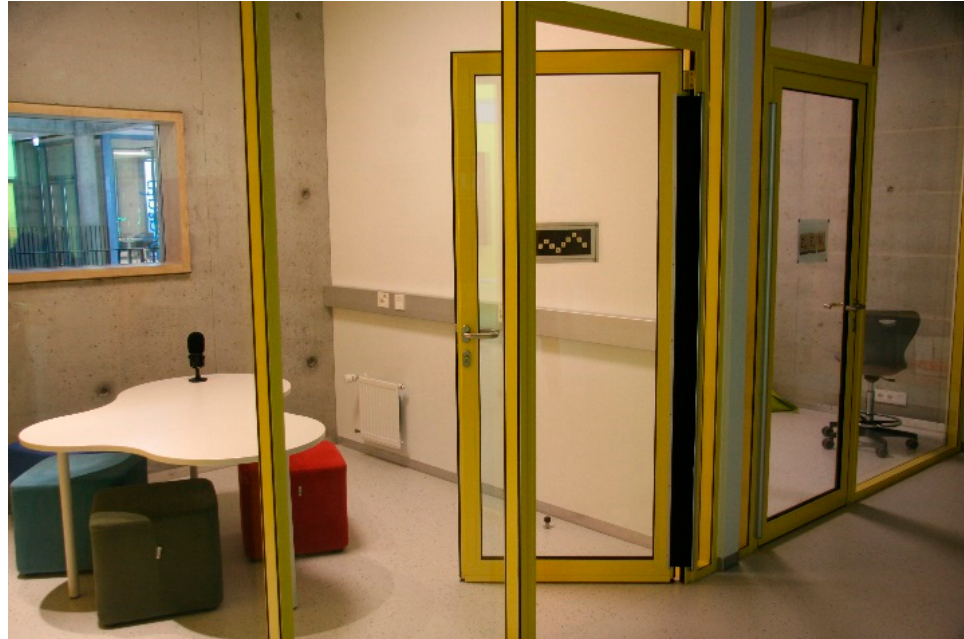
Figure 7. Breakout cells with recording devices and a selection of furniture. Windows connect the cells with the hallway areas outside the tvennd or classroom.